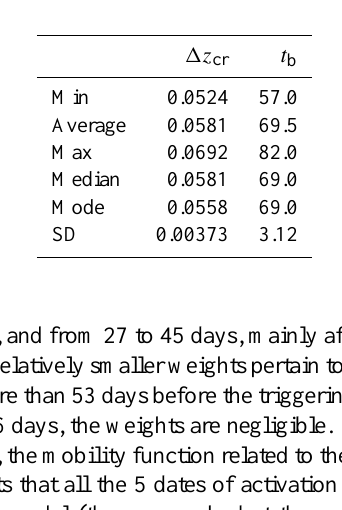
Figure 12. Sorrento Peninsula case study. Kernels providing (a) the best fitness ( (cid:56) max = 0.807), (b) the minimum base time t b min (26 days), (c) the (cid:49)z cr max (0.00801), and (d) the minimum first- order momentum, µ 0 min (9.460). Table 6. Uncino landslide case study. Statistics for the 100 best ker- nels.